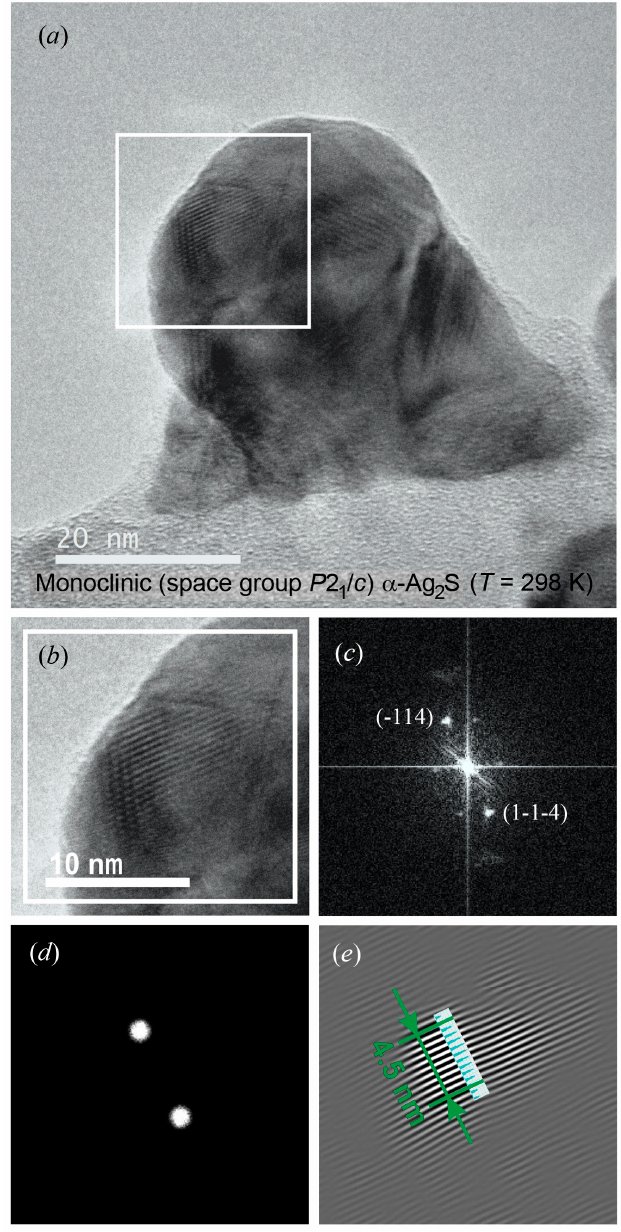
Figure 15. ( a ) HRTEM image of colloid Ag 2 S nanoparticle; ( b ) magnified HRTEM image of the nanoparticle area highlighted by a white square; ( c ) electron diffraction pattern for the same area calculated by the FFT of the magnified HRTEM image; ( d ) a mask created from FFT; ( e ) calculation of inverse FFT with mask using, and generation of line scale of interplanar distances.